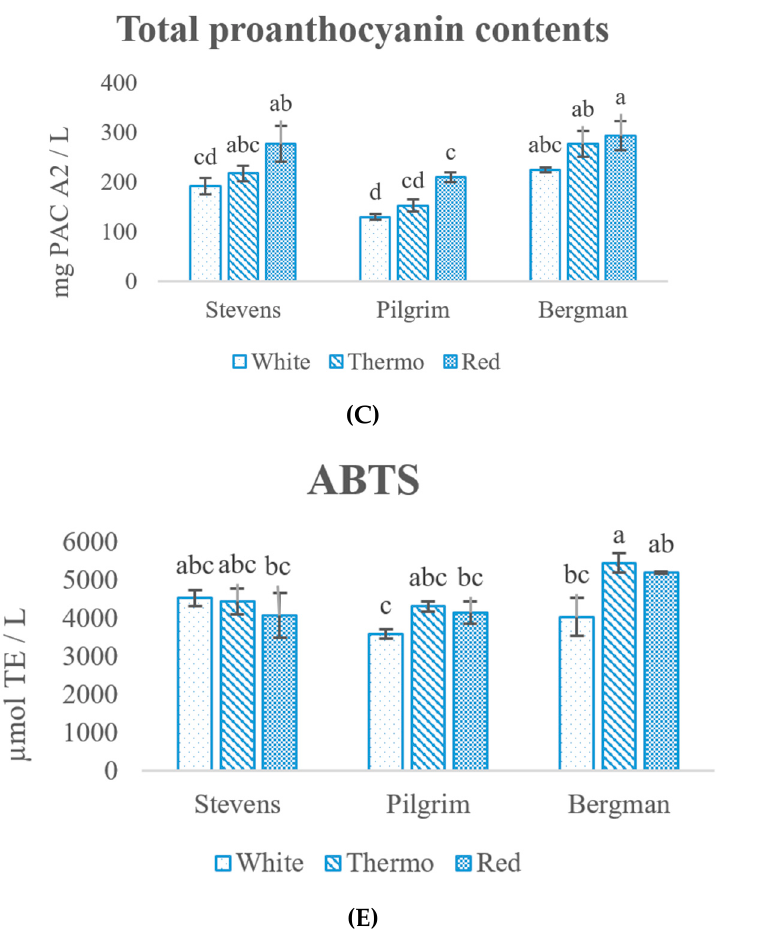
Figure 1. Total phenolic (TPC) ( A ), anthocyanin (ANC) ( B ), proanthocyanin (PAC) ( C ) contents and antioxidant capacities (AOC) ( D ) FRAP (ferric reducing ability of plasma method), ( E ) ABTS (free radical-scavenging activity method) of the wine samples determined by spectrophotometric assays. Values identified by the same letters are not significantly different at the 0.05 level (One-way ANOVA-Tukey ab ).